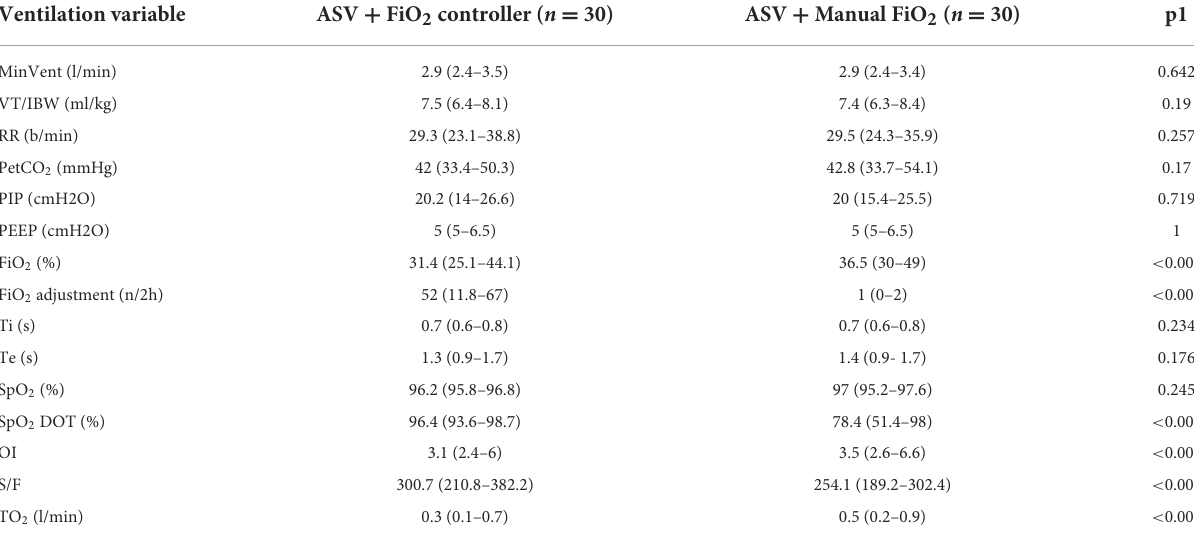
TABLE 3 Ventilation parameters during study phases.